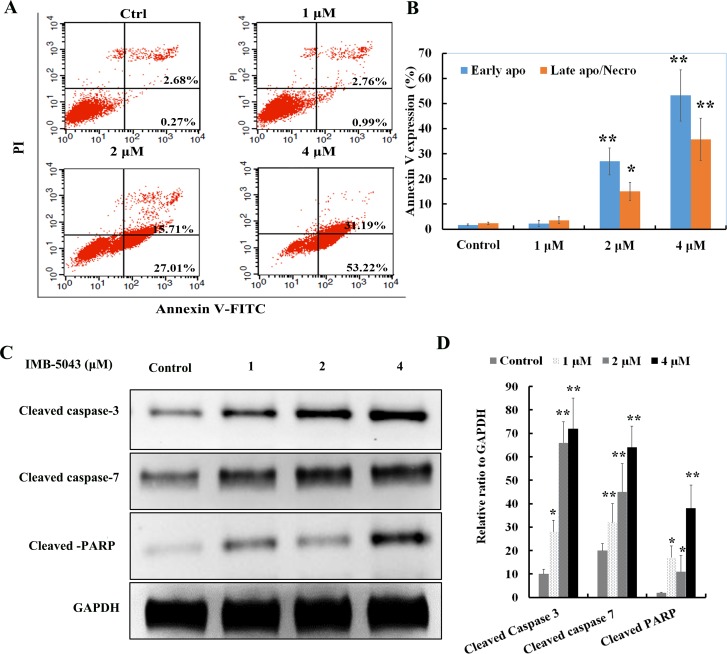
IMB5043 induces apoptosis of in SMMC-7721 cells.(A). Flow cytometry analysis of apoptosis in SMMC-7721 cells treated with IMB5043. Representative pictures from three experiments is shown. (B). Quantification of apoptosis rate in SMMC-7721 cells treated with IMB5043. Cells were stained with FITC-Annexin V/PI. Apoptosis is determined by the percentages of FITC-Annexin V+ cells. The lower-right quadrant shows the early apoptotic cells, the upper-right quadrant shows necrotic or late apoptotic cells, and the upper-left quadrant shows necrotic cells or nuclear debris, and the lower-left quadrant shows healthy, viable cells. *P<0.05; **P<0.01. (C). Western blot showed the levels of apoptosis-related proteins including in SMMC-7721 cells. SMMC-7721cells were treated with IMB5043 at indicated concentrations for 24 h, then caspase-3, 7, and PARP was detected. Representative images of three independent experiments are shown. (D) The histogram shows the relative density of proteins shown in (C).Data represents the mean ± SD of three independent experiments. Results were derived from three independent experiments. *P<0.05; **P<0.01.